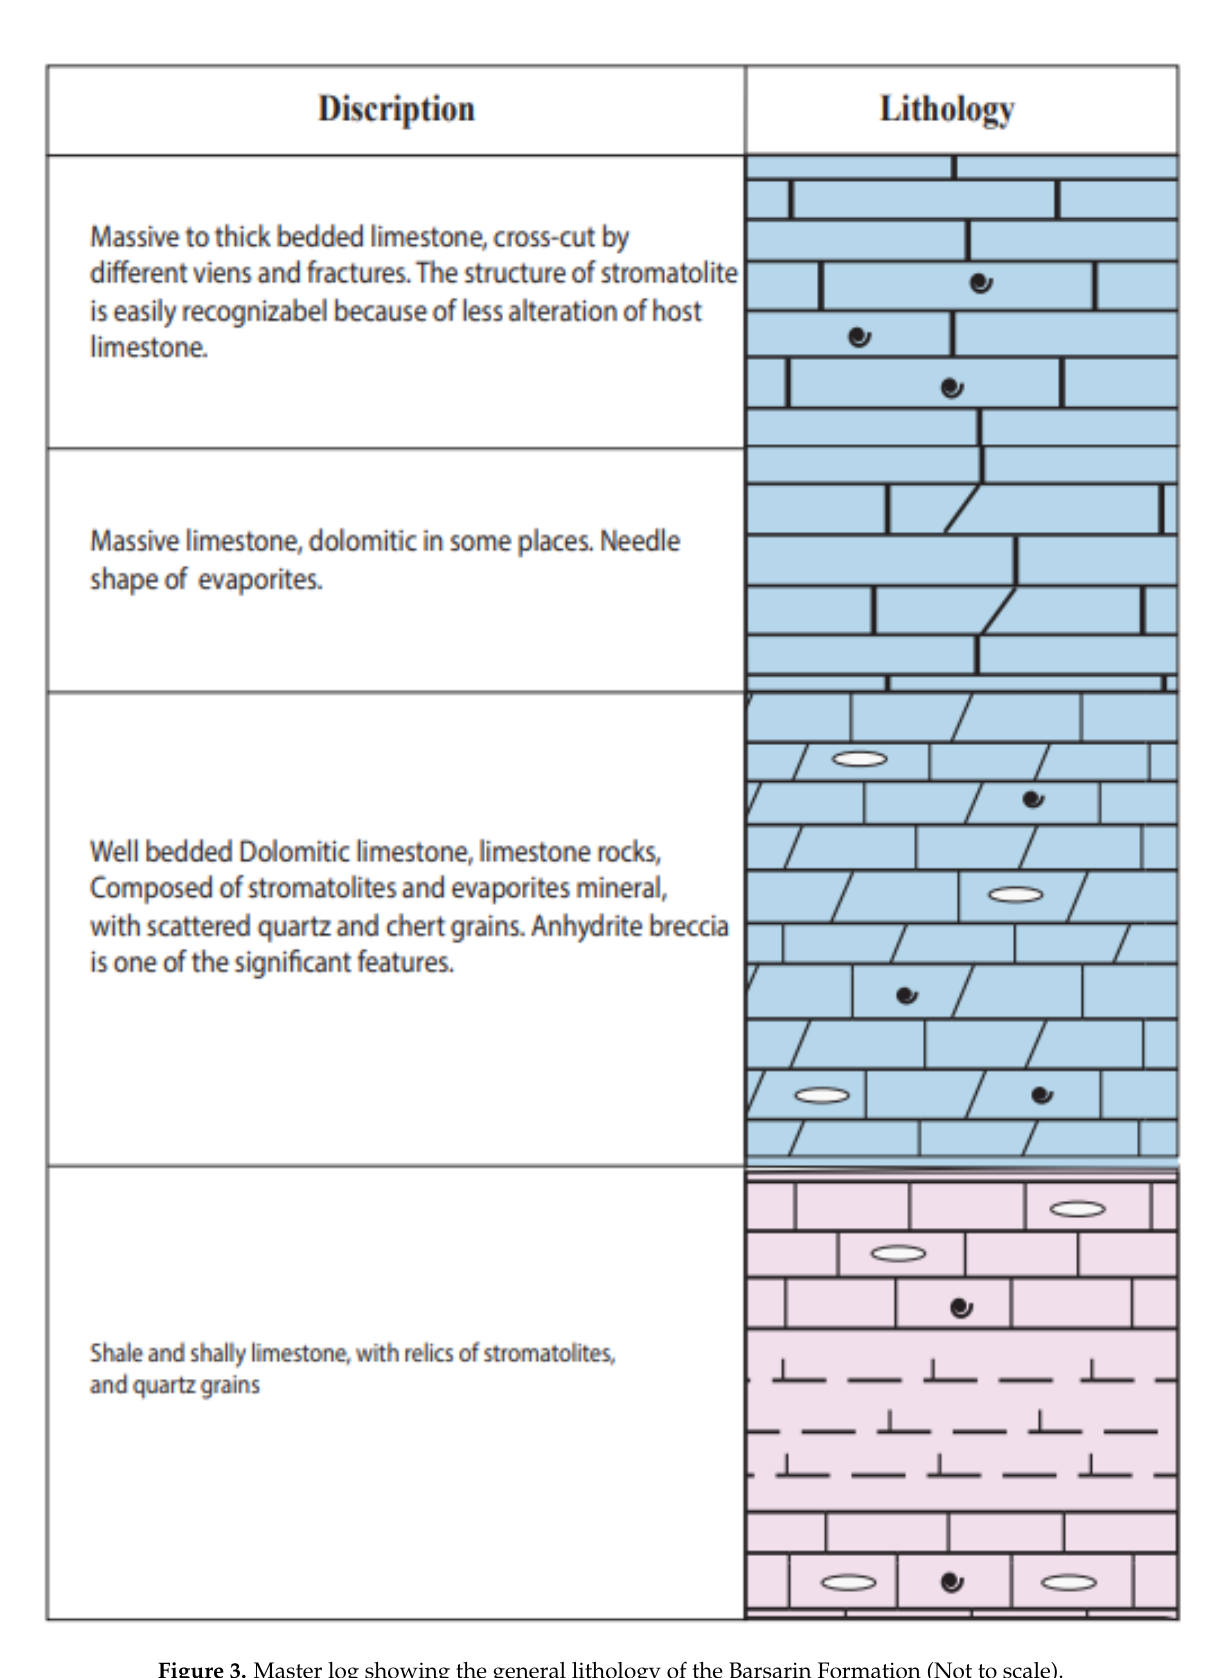
Figure 3. Master log showing the general lithology of the Barsarin Formation (Not to scale).